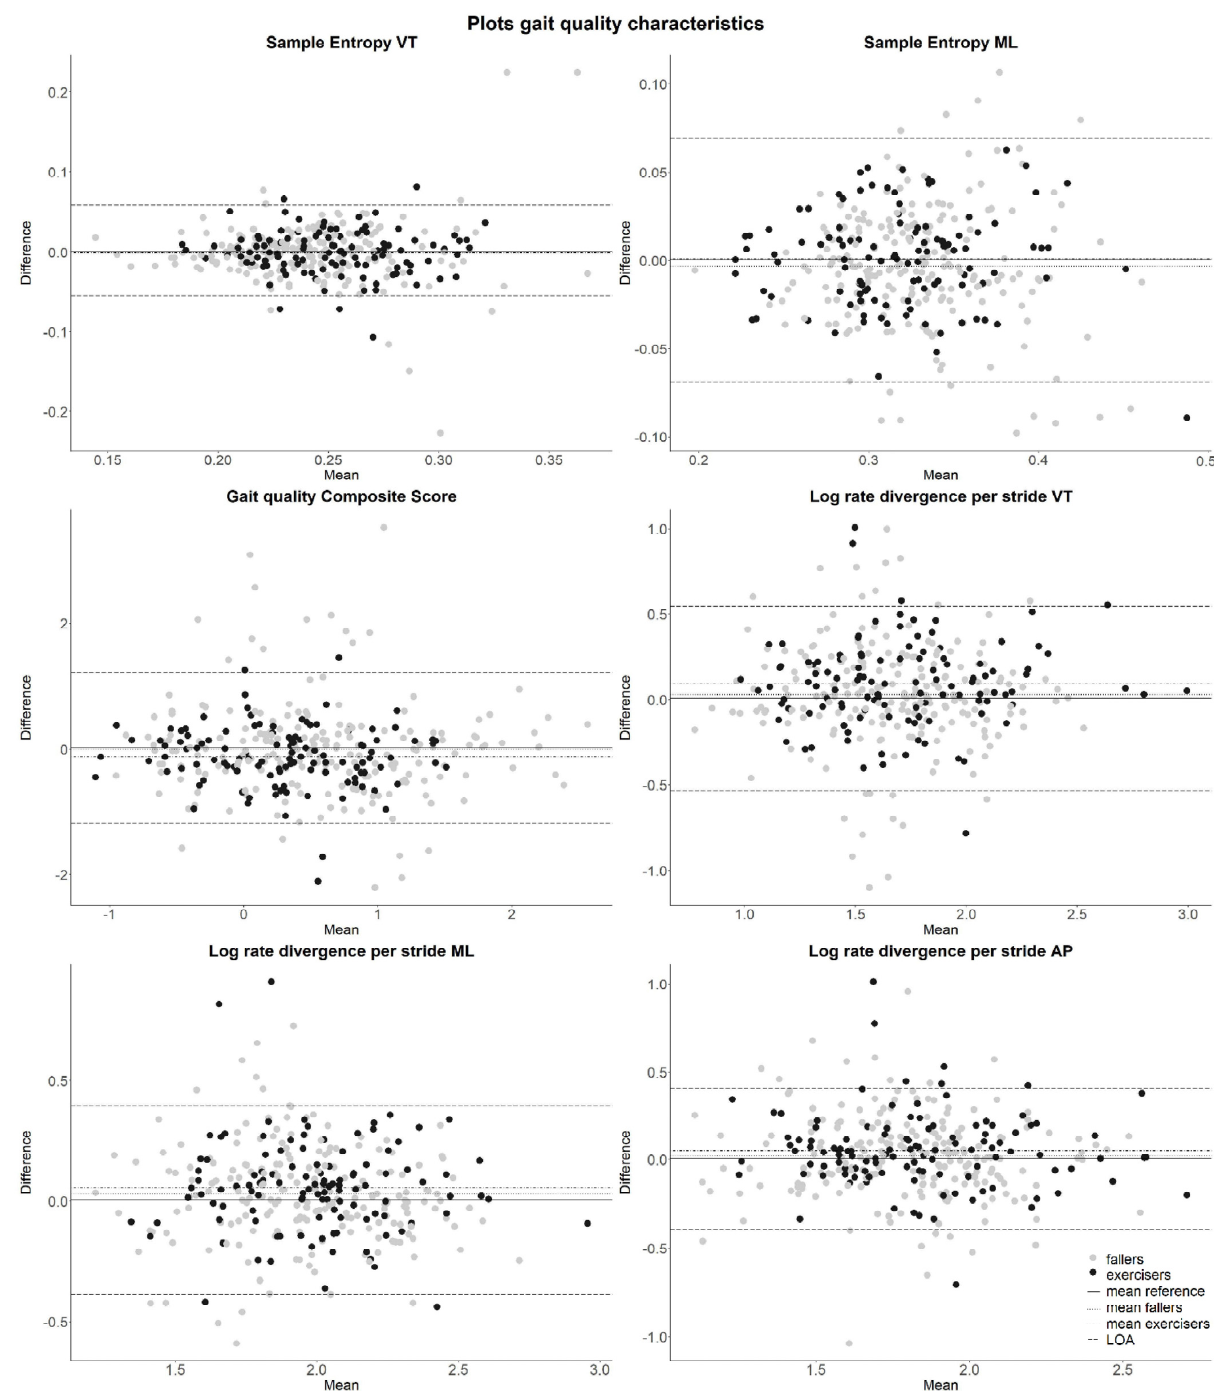
Figure A2. Gait quality characteristics unadjusted for walking speed. Note: Positive difference in sample entropy in ML and gait quality composite and negative difference in sample entropy in VT or logarithmic rate of divergence in VT, ML, or AP indicates an increase in gait quality over one year. Continuous line is mean change in the reference group. Long dashed lines are the LOA. Dotted line (mean change in the fallers) and dot-dashed line (mean change in the exercisers) are sometimes overlapping the continuous line.